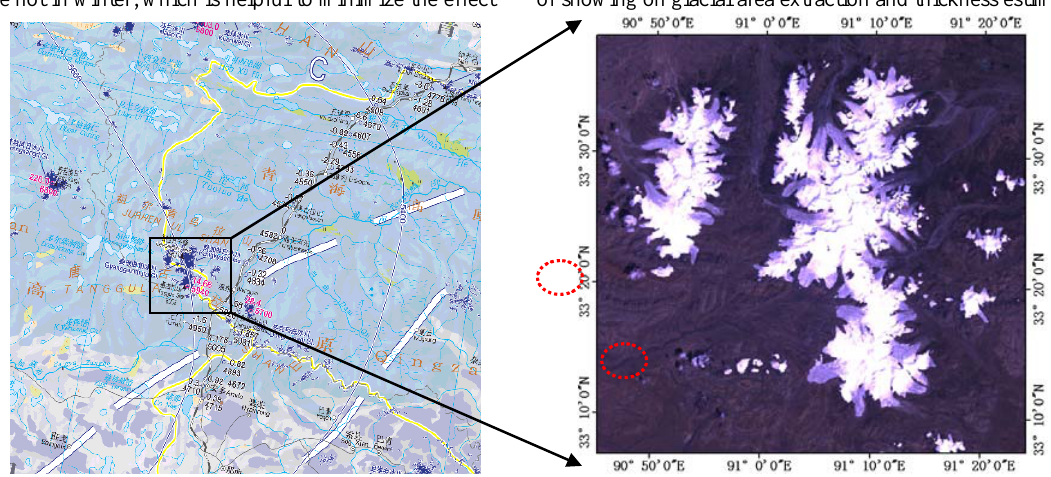
Figure.1 Location of the Geladandong Mountains. Glaciers are in white color in the right image. Please note, there are some clouds in the west of the glaciers, as masked by the red dash line ellipses. visible bands, but low reflectance values in the mid-infrared band.